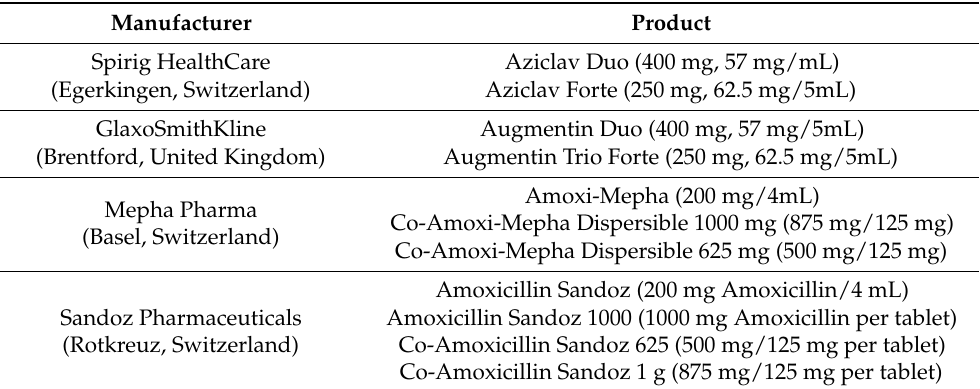
Table 1. Tested commercially available co-formulated and non-co-formulated products. Manufacturer